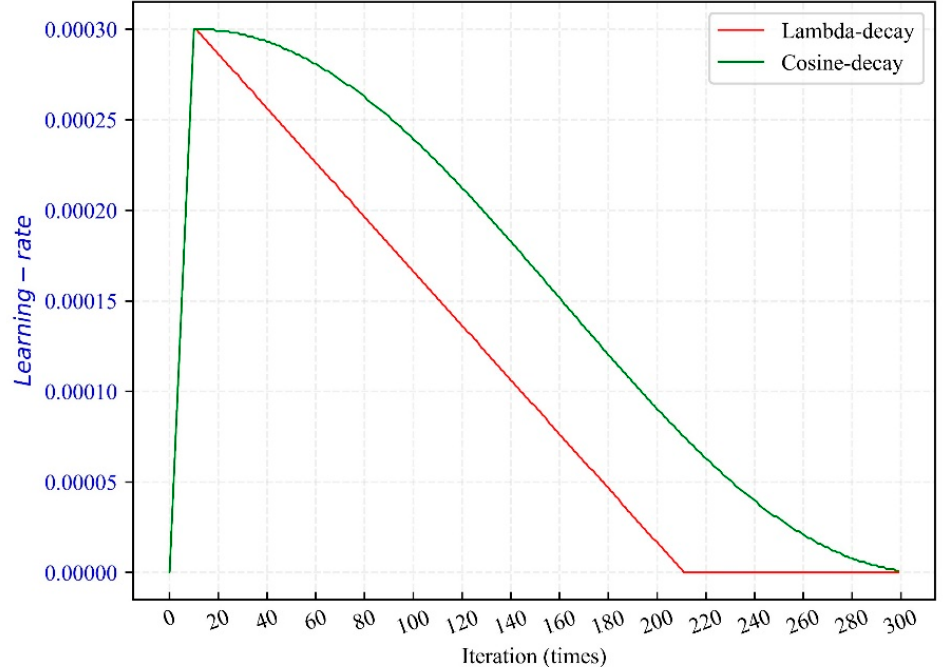
Figure 8. Gradual warm-up learning-rate curves of cosine and lambda decay